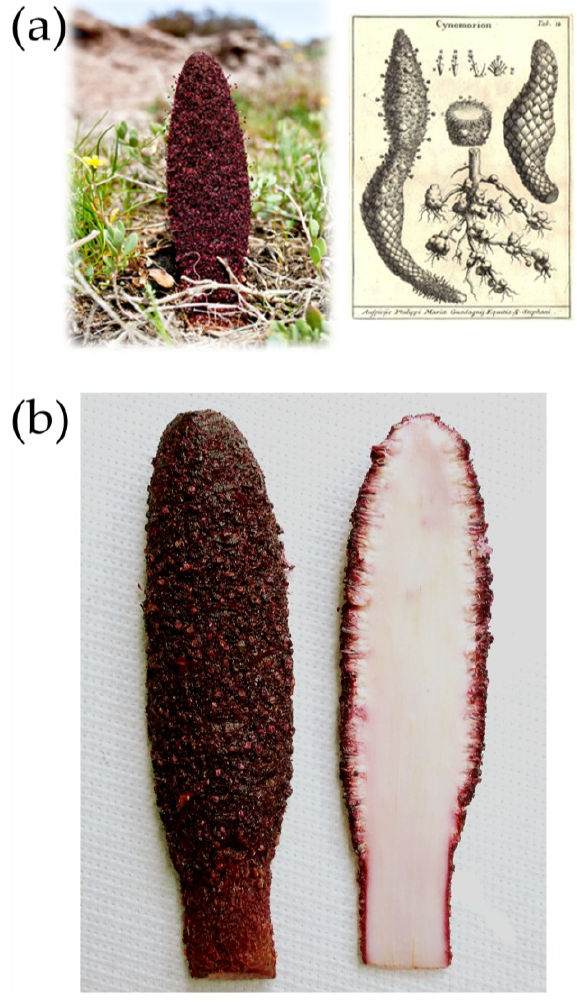
Figure 1. ( a ) Left, Cynomorium coccineum (Maltese mushroom), growing in a coastal area at Portoscuso, south-western Sardinia, Italy. The above ground height of the specimen was approx 20 cm; Right: A classic view of ―fungus‖: ―Cynomorion‖ from Nova Plantarum Genera , P.A. Micheli (1729). ( b ) Slices of a specimen that show the comparison between the outside colored and the inner